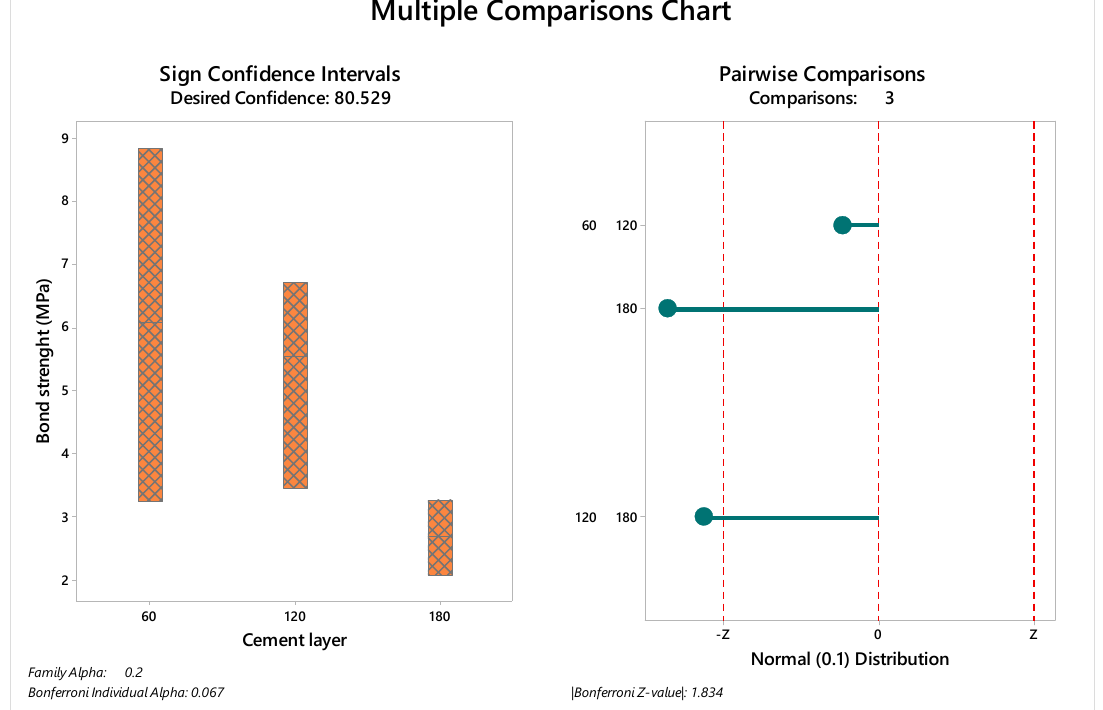
Figure 4. Multiple comparison chart for aged groups (60, 120 and 180 μ m). The sign of confidence was calculated considering family alpha = 0.2 and Bonferroni individual alpha = 0.067. The pairwise comparison demonstrated 1.83 as the Bonferroni Z-value with visible differences between the evaluated cement layers. Table 5. Confidence intervals, achieved confidence and data position according to the cement layer thickness for aged groups.